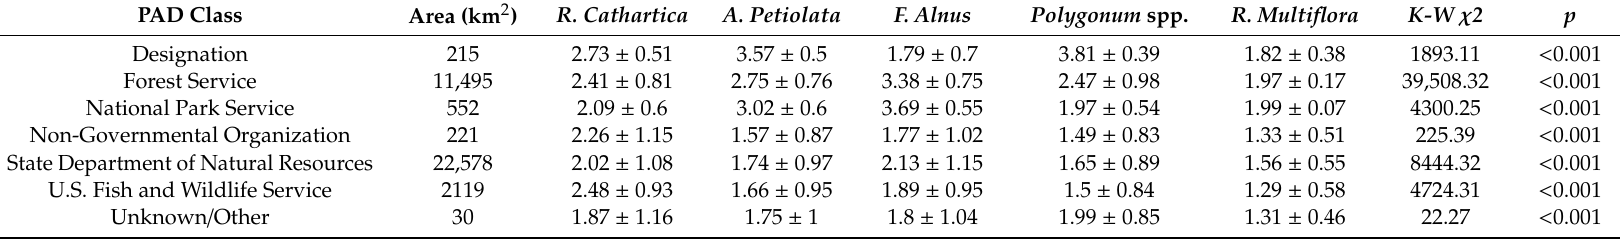
Table 4. Distribution of priority classes across Protected Areas Database (PAD) classes for each species. Priority classes correspond to very low = 1, low = 2, medium = 3, and high = 4. Values ± 1 standard deviation. Only PAD classes with ≥ 30 km 2 area are